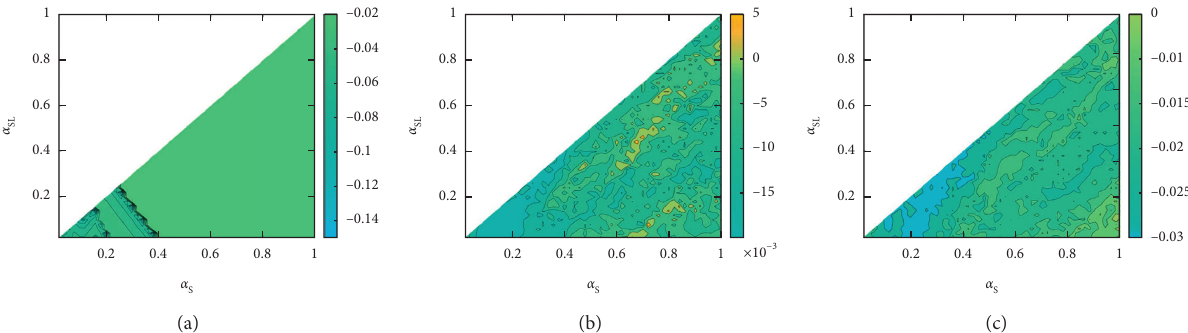
Figure 16: LLE diagram of supply chain nodes under the scenario of random demand obeying normal distribution from local perspective � 6. (a) The retailer’s LLE chart. (b) The LLE chart of the distribution center. (c) The LLE chart of the combined system when G d � 3 and G 1 from the decision perspective.